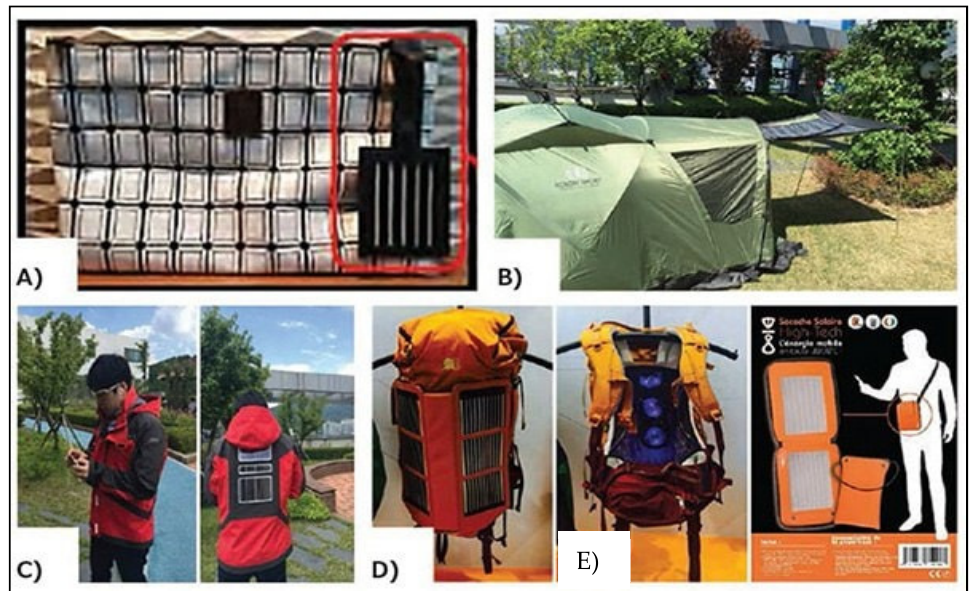
Figure 33. ( A ) Tailor-made smart bag by Kolon Industries, integrating an organic solar panel energy harvester (outlined with red rectangle) and NFC technology. ( B ) Star Tent by Kolon Industries, integrating LED lighting with OPV as the energy source. ( C ) Smart jacket integrating an OPV module, LED, and Bluetooth by Kolon Industries. ( D ) Backpack by Kolon Industries, integrating OPV as the power source for cooling fans. ( E ) Solar bag designed and manufactured by Armor using ASCA© photovoltaic films as the source of energy.